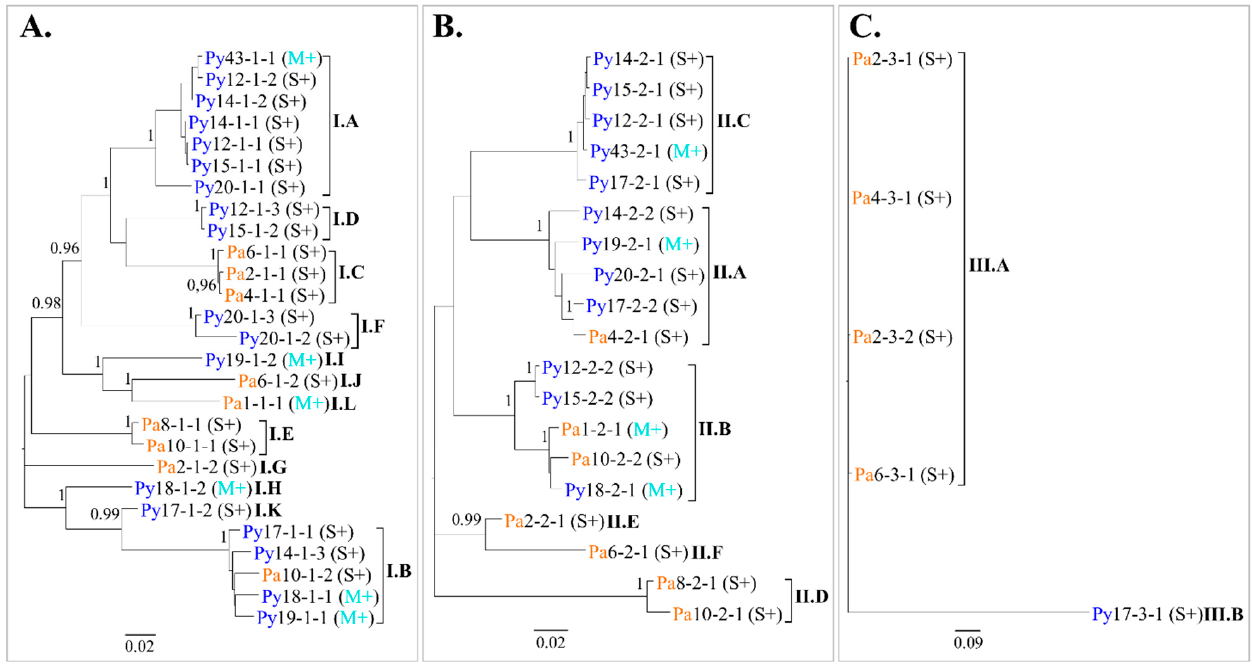
Figure 5. Phylogenetic relationships between grapevine fanleaf virus (GFLV) molecular variants. Maximum likelihood trees were inferred from the complete nucleotide sequences of ORF1 ( A ), ORF2 ( B ) and ORF3 ( C ) recovered from GFLV-infected ‘Chardonnay’ vines. Each sequence name indicates the vineyard site (Pa, in orange and, Py, in deep blue), the sampled vine, the molecular variant and the vine affiliation to a phenotypic category (M+, in cyan and S+, in black) in parenthesis. Clades are named with the Roman numeral corresponding to the GFLV ORF and classified from the most [A] to the least [L] represented clade in sequence number. The names of the distinct clades are highlighted in bold. Sequence variants sharing at least 95% nucleotide identity were considered in the same clade; pairwise nucleotide identities values between GFLV sequences are available in Table S6. Scale bars below each tree show genetic distance. Only bootstrap values ≥ 0.95 are indicated.